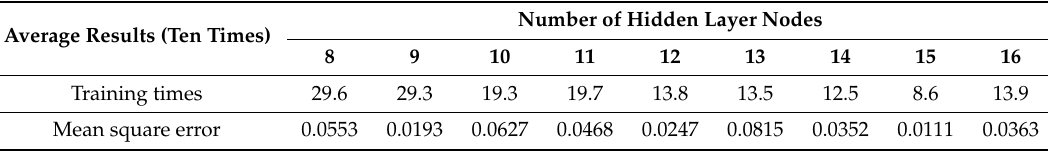
Table 2. Verification of the number of nodes in the hidden layer of BP neural network. Average Results (Ten Times)